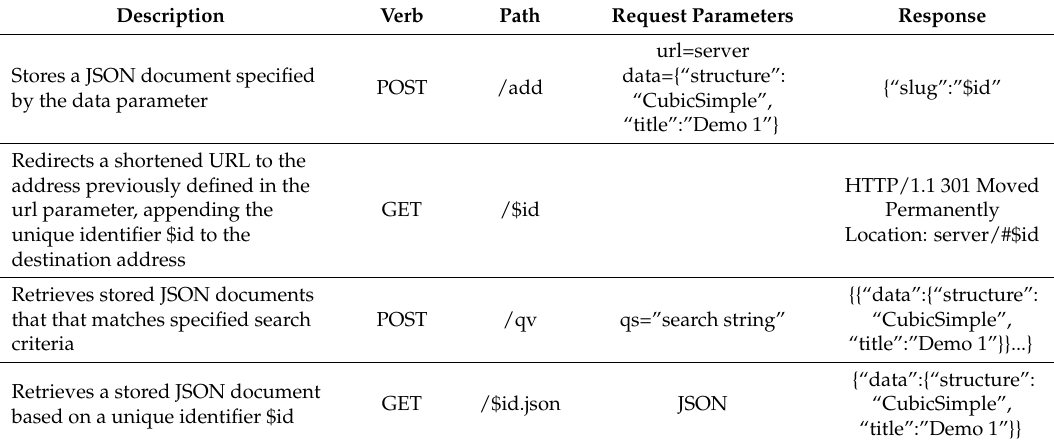
Table 3. Description of routes, verbs and parameters of the CWLY REST interface.